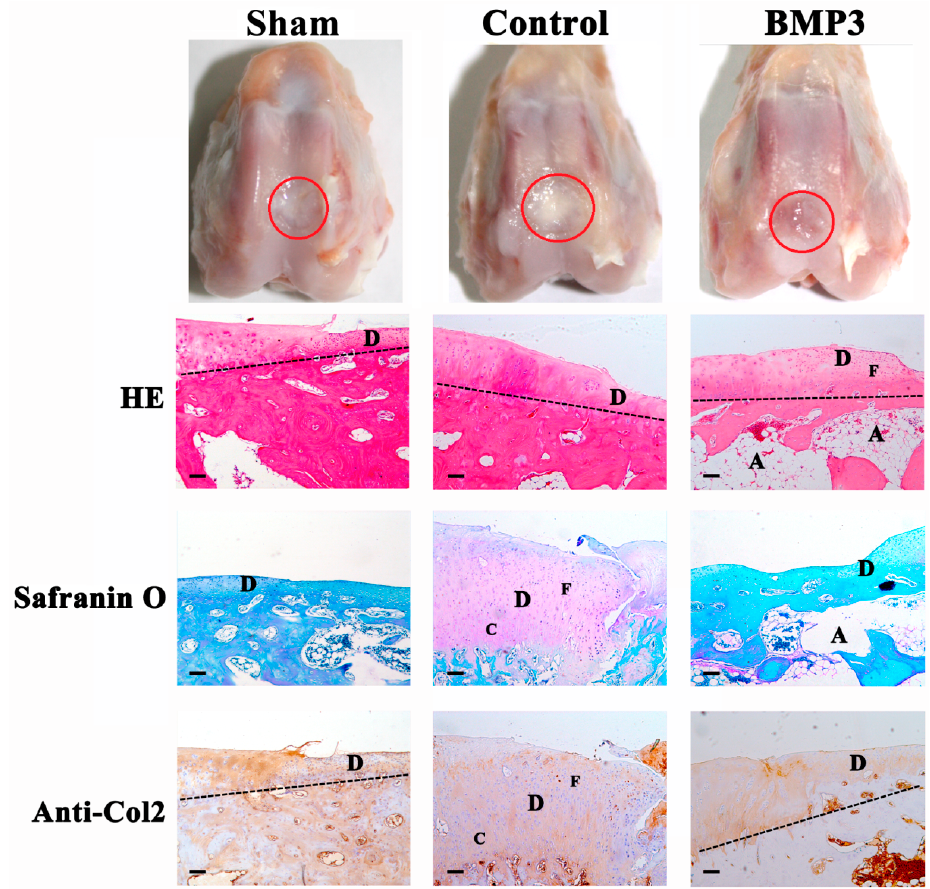
Figure 2. Macroscopic and histological observation of the repaired tissue in full-thickness defect at eight weeks post-operation. The red circle regions are the defects of articular cartilage. Sections were stained with HE, Safranin O, or immunohistochemical collagen type II (Anti-Col2). Sham, sham-operated group; Control, group only treated with collagen membrane without BMP3 as negative control; BMP3, group treated with the collagen membrane and BMP3 at 100 ng/cm 2 , respectively. The dash line stands for the boundary between articular cartilage and subchondral bone. D, C, F, A stand for defect area, chondrocyte-like cells, fibrocartilage cells, cavities, respectively. Scale bar is 100 μ m.